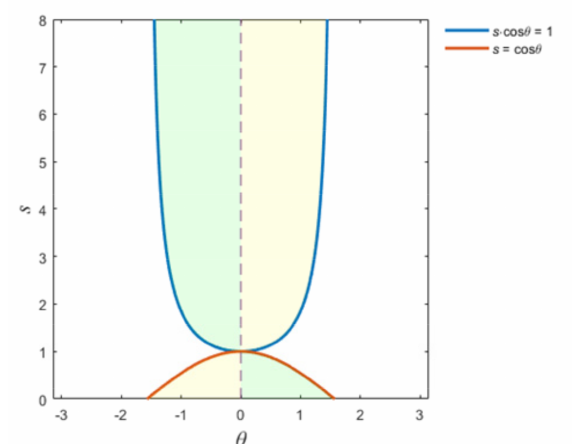
Figure 8. Regions for curvature variation of typical B é zier curves. Curvature decreases in the light yellow area and increases in the light green area. While in the white area, curvature variation is not monotonous and possesses only one extremum. Specifically, for θ < 0 there is a local minimum and for θ > 0 there is a local